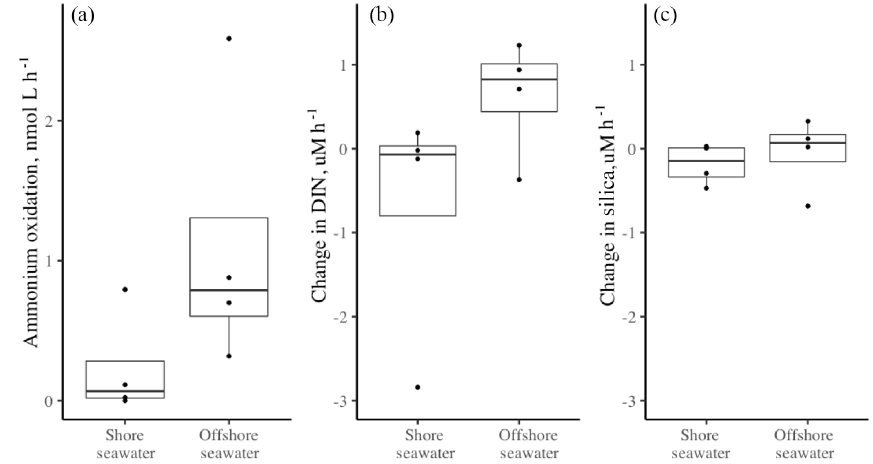
Figure 3. (a) The ammonium oxidation rate (nmolL − 1 h − 1 ) in surface seawater collected at the shore versus 2–5km offshore, based on four trials in each locale in June and July of 2012. The rates did not differ ( t = t 3 . 8 = 1 . 65, p = 0 . 177). The change in (b) DIN and (c) silica (nmolh − 1 ) also did not differ whether seawater was from the shore or offshore ( b DIN t 3 . 8 = 1 . 31, p = . 260; c silica t 3 . 8 = 0 . 68, p = 0 . 525). Boxplots as in Fig.